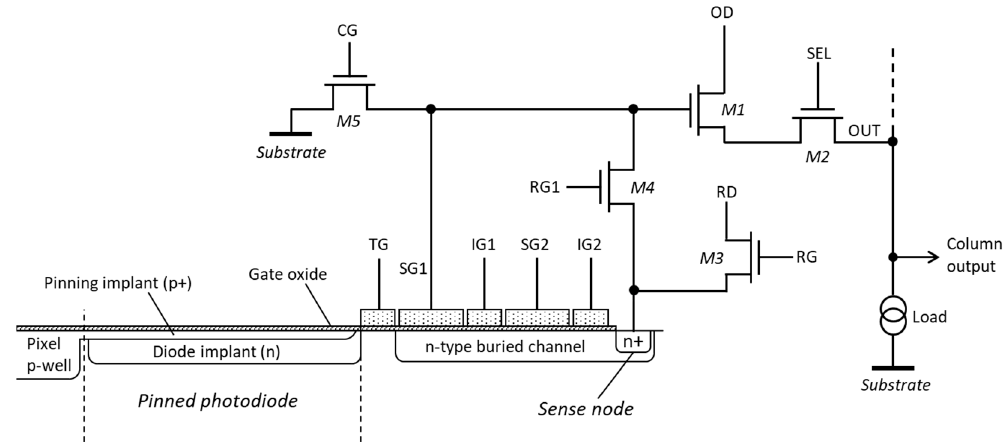
Figure 1. Diagram of the proposed pixel.